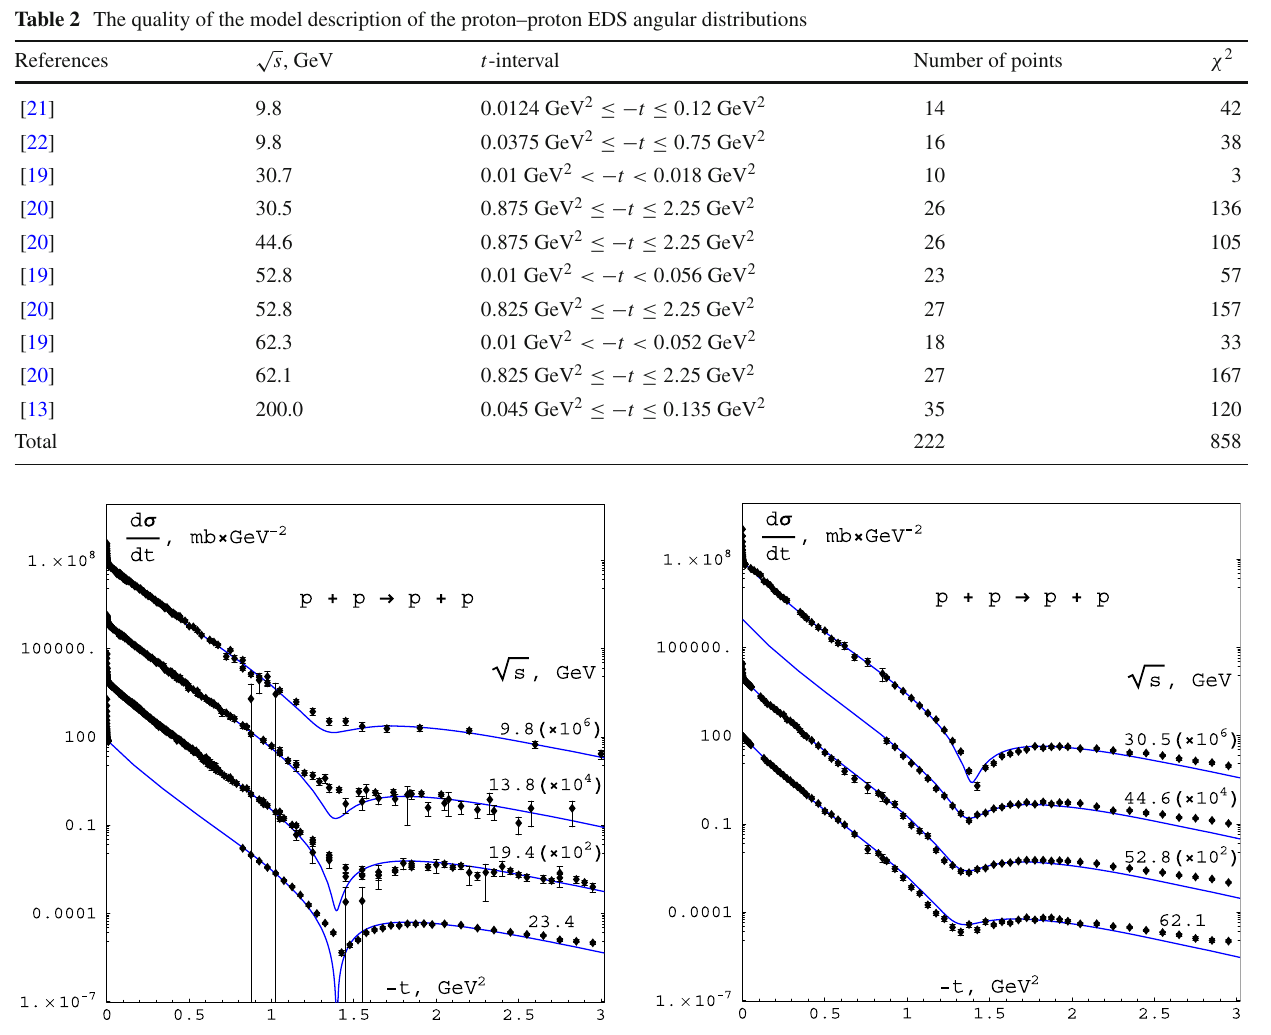
Fig. 3 The differential cross-sections of proton–proton EDS at high energies and low transferred